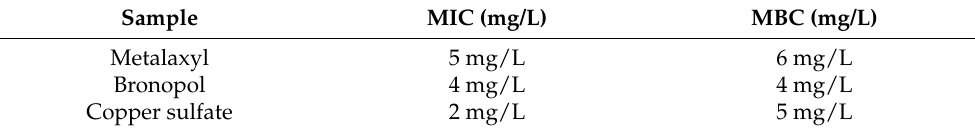
Table 1. MIC and MBC values of metalaxyl, bronopol and copper sulfate against Saprolegnia parasitica . Sample MIC (mg/L) MBC (mg/L) Metalaxyl 5 mg/L 6 mg/L Bronopol 4 mg/L 4 mg/L Copper sulfate 2